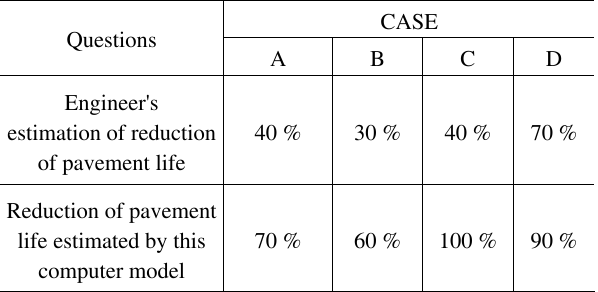
Table 4 . Average reduction of pavement life that estimated by road engineers and this model